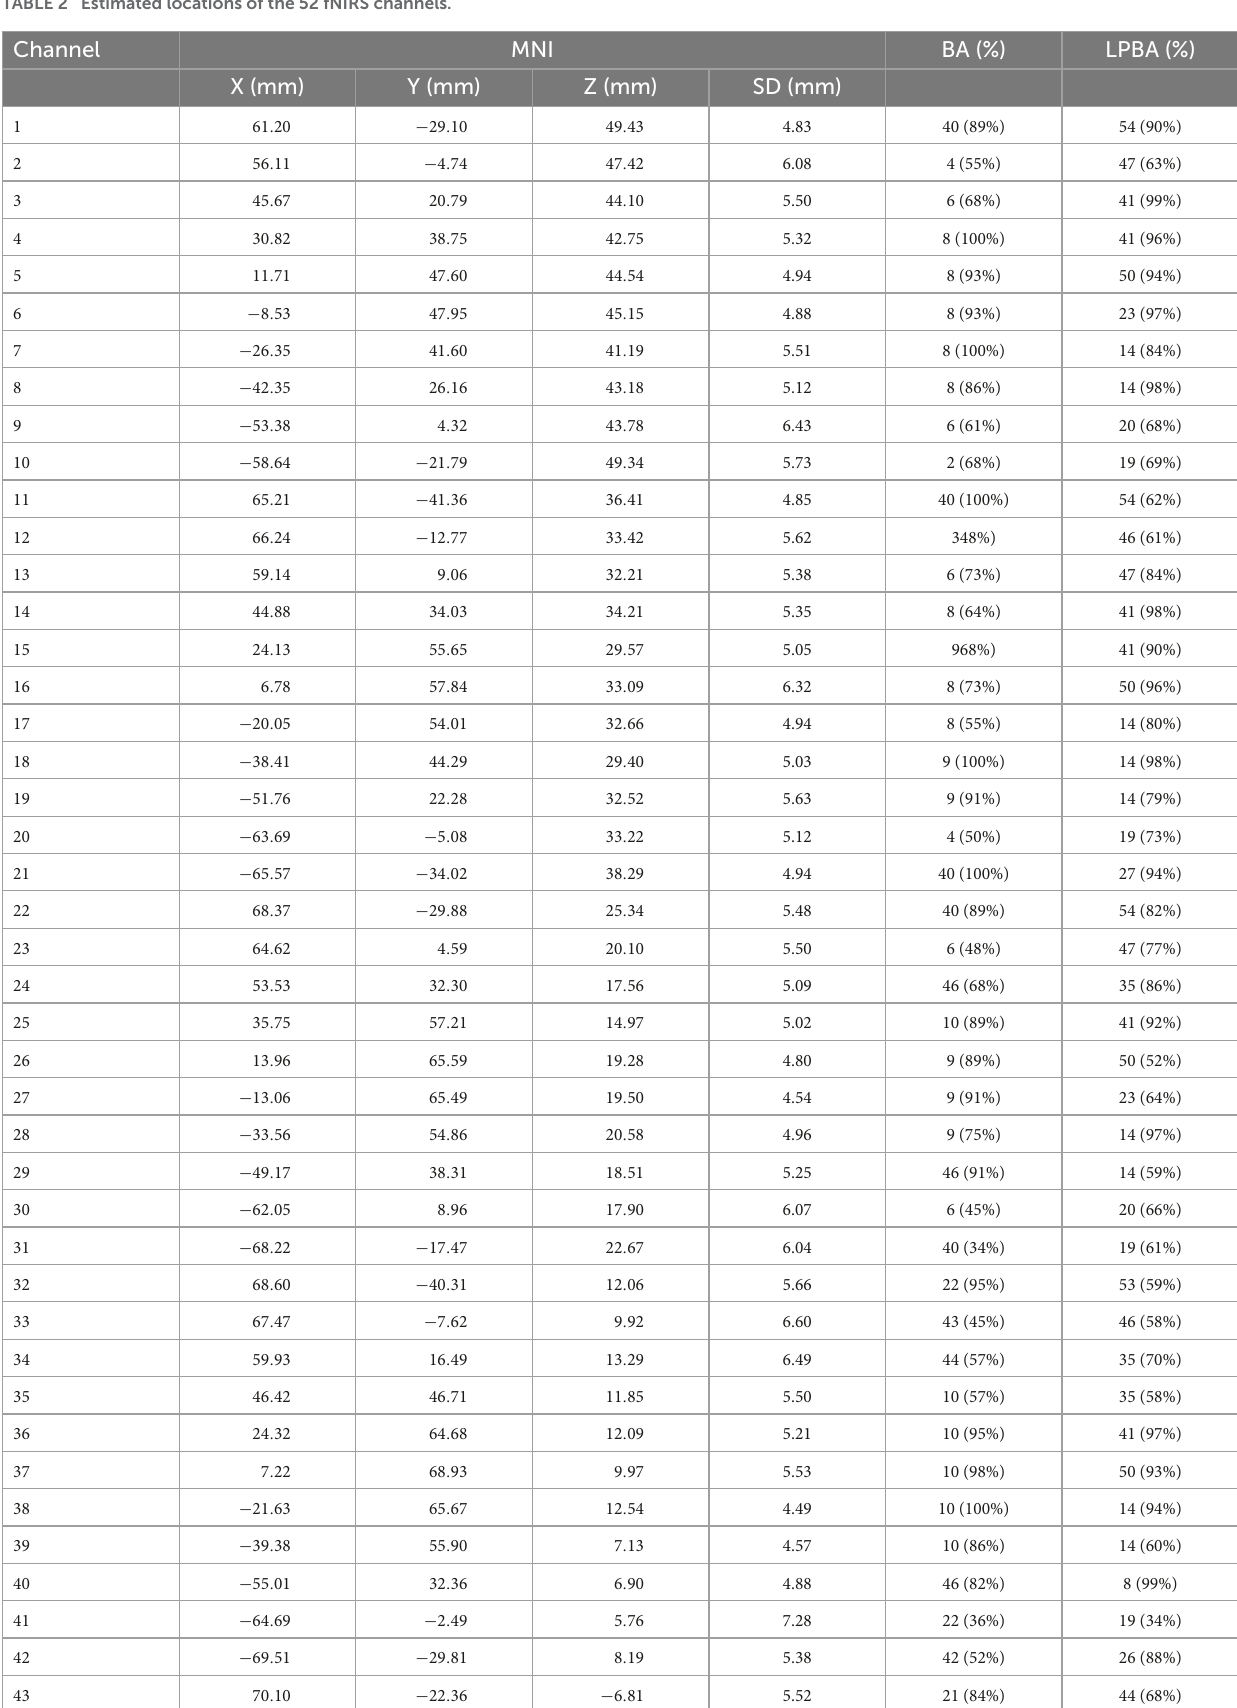
TABLE 2 Estimated locations of the 52 fNIRS